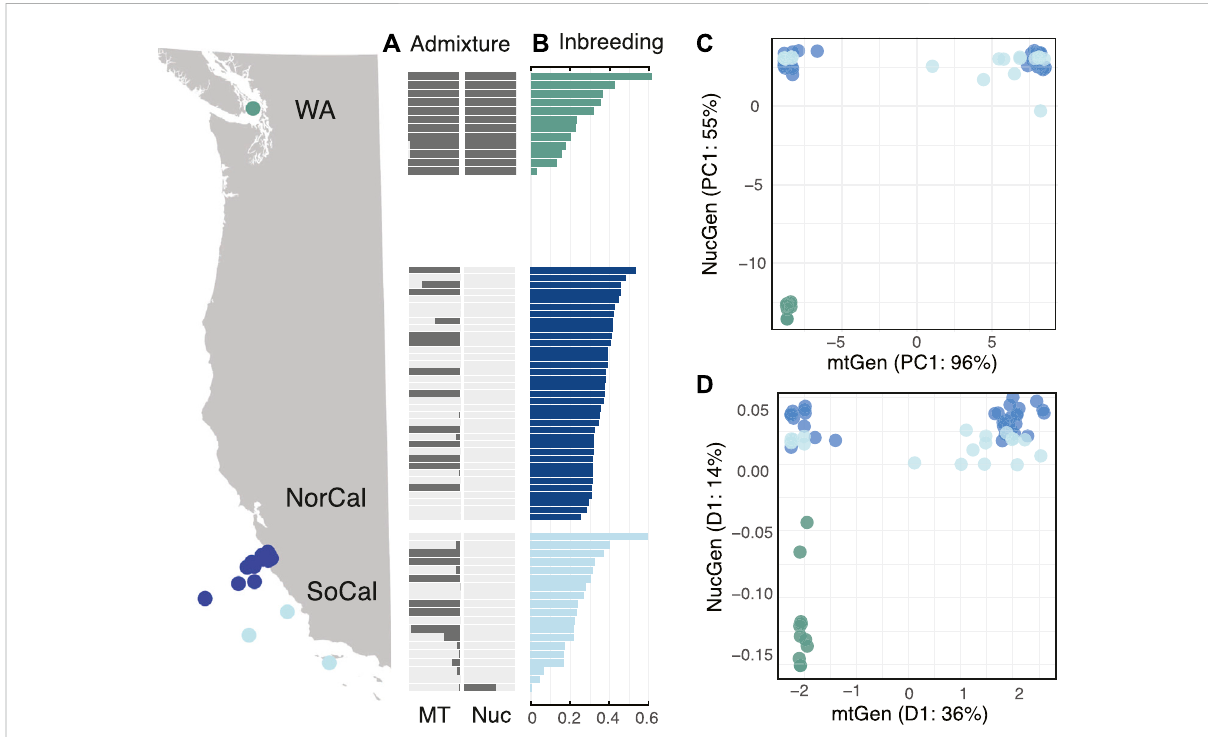
FIGURE 4 Population genomic results of the three populations including WA (green), NorCal (blue), and SoCal (light blue) for (A) NGSadmix results for mitochondrial and nuclear genomic assignment tests for two populations, sorted by (B) per-individual inbreeding coef fi cients, (C) fi rst principal componentfromPCAestimatesofnucleotidediversityformitochondrial(x-axis)versusnuclear(y-axis)genomes,and (D) fi rstdimensionsofMDSof genetic distances for mitochondrial (x-axis) versus nuclear (y-axis)